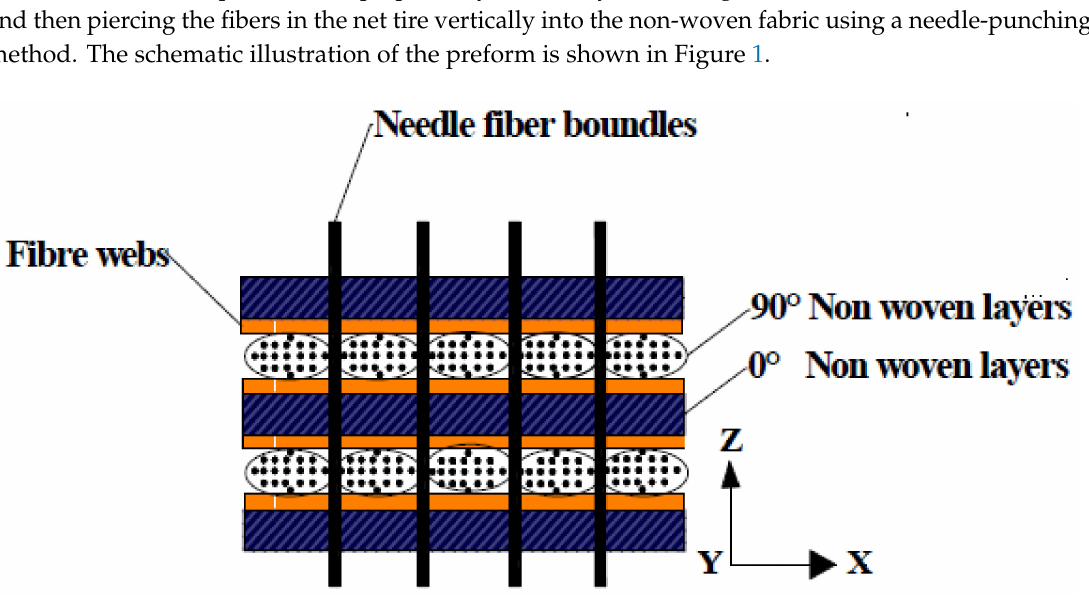
Figure 1. The schematic of the architecture of the 3D needle-puncture fiber